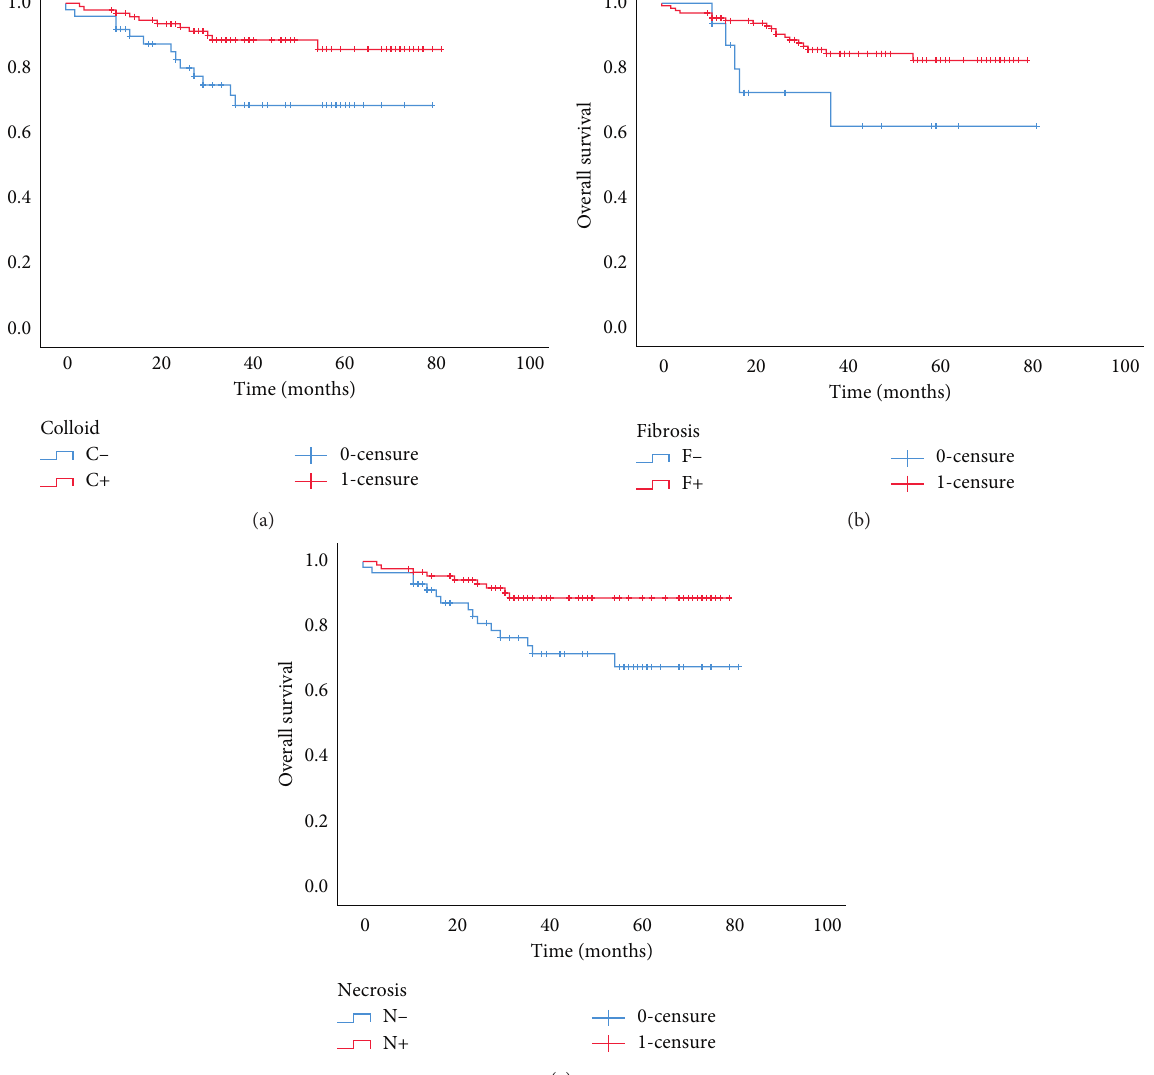
Figure 4: Kaplan–Meier curves for the duration in months of OS according to the (a) presence of colloid (C+: presence of colloid and C − : absence of colloid), (b) presence of fibrosis (F+: presence of fibrosis and F − : absence of fibrosis), and (c) necrosis effect (N+: presence of necrosis and N − : absence of